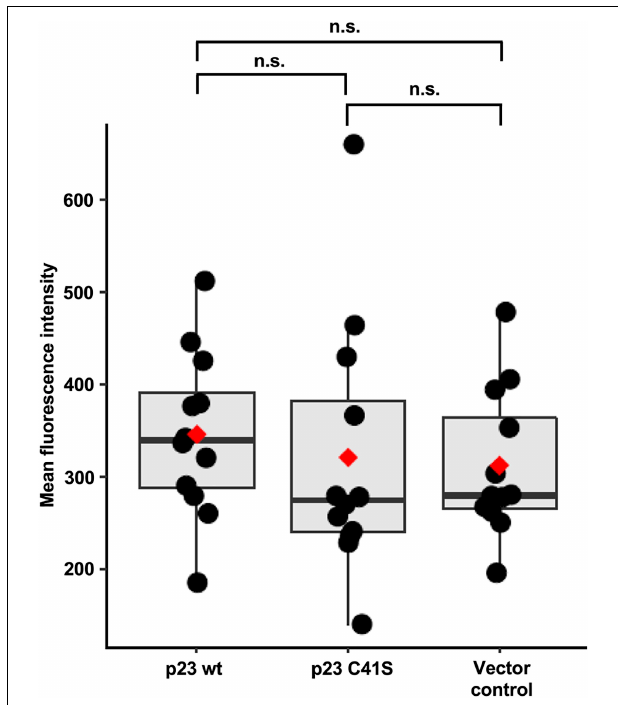
FIGURE 7 | Flow cytometry Ca 2 + flux measurements. Mean fluorescence intensity was measured for 25,000 cells in each condition, with three replicates per condition. Boxplots represent the distribution of mean fluorescence intensity value. Median values are shown as a horizontal line and mean values as a red diamond. The results from four independent experiments were normalized and combined. Significance was analyzed using one-way Kruskal-Wallis test and pairwise Wilcoxon rank test with multiple testing correction; adjusted p -values are shown above the plot; the plot was produced using ggplot2 (Gómez-Rubio, 2017); n.s., not significant ( p >